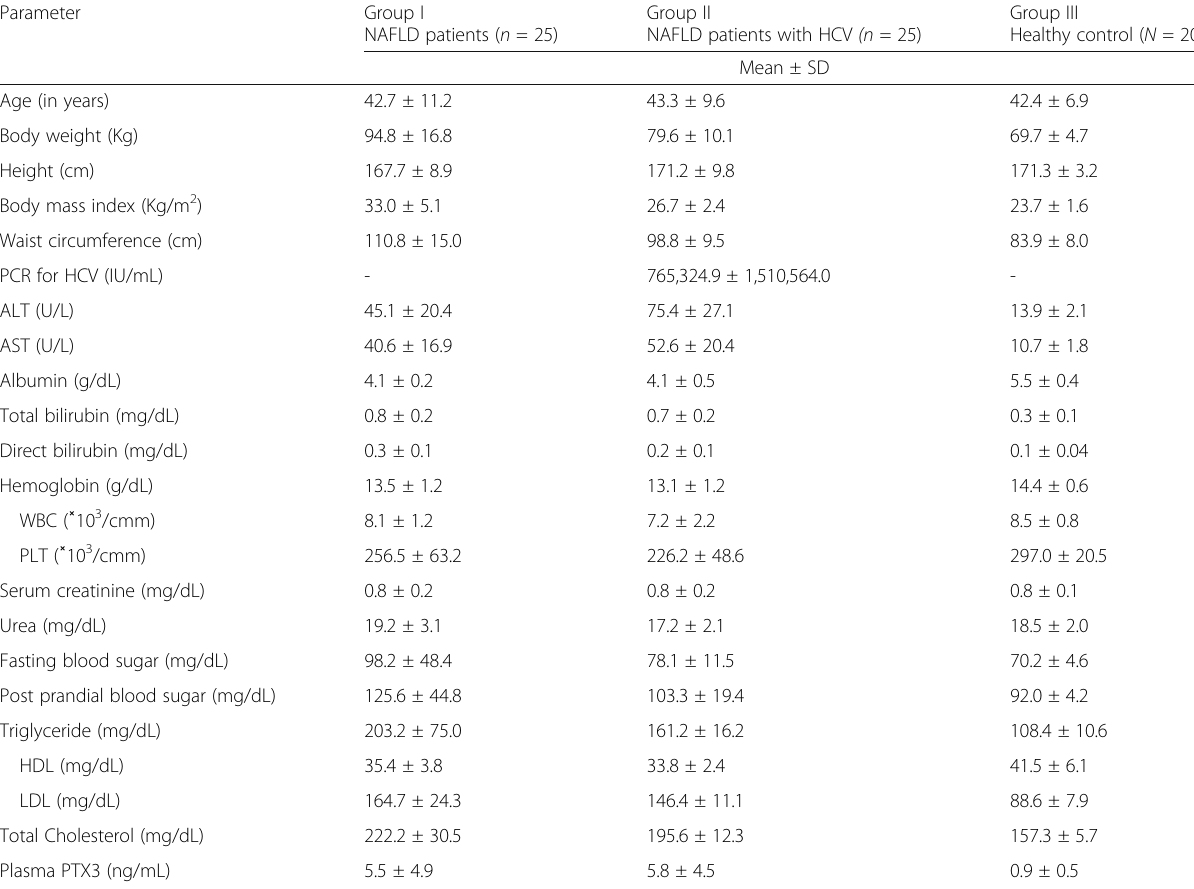
Table 1 Characteristics of the three study groups